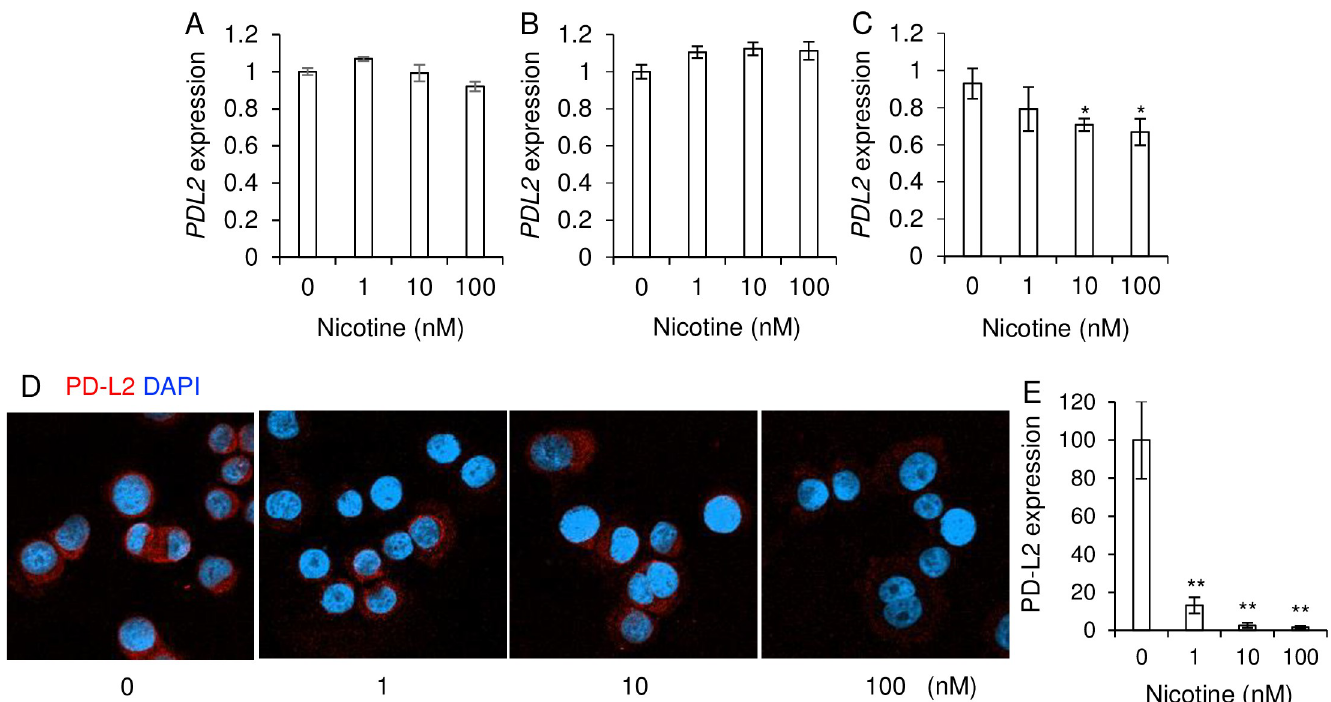
Fig 3. The effect of nicotine treatment for PD-L2 expressions on breast cancer cell lines. (A-C) Breast cancer cell lines, HCC1937 cells (A), MDA-MB-231 cells (B), and SK-BR-3 cells (C) were stimulated with nicotine (0–100 nM) and the relative mRNA expressions of PD-L2 to those without the stimulations (nicotine 0 nM: Relative expression = 1) were measured by qPCR (n = 4 each). (D, E) SK-BR-3 cells were cultured in the absence and presence of nicotine (1, 10 and 100 mM) and were stained with anti-PD-L2 antibody. DAPI was used for detecting nuclei. (D) One of the representative figures is shown (n = 5 each). (E) The relative expression of PD-L2 was determined by using ImageJ. Each mean ± SEM is shown. � p < 0.05 and �� p < 0.01.